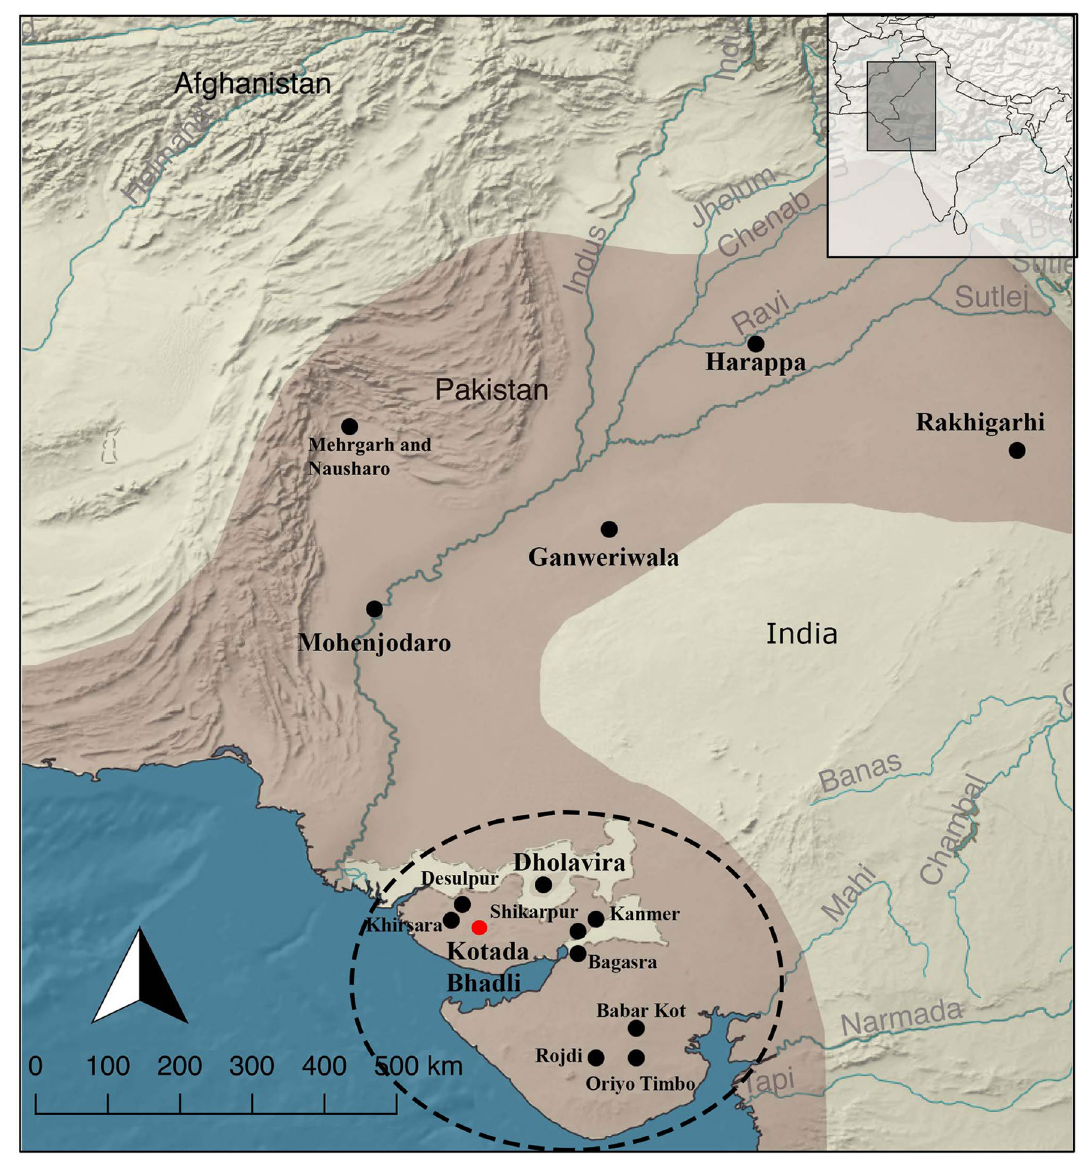
Figure 1. Highlighted map of the Indus Civilization showing the location of major settlements and settlements that are mentioned in this paper. The black dashed lines indicate the region under study and the red dot indicates the site under study. The map was created using QGIS Desktop version 2.18.14 (www.qgis.org), and raster and vector map data was acquired from Natural Earth (https ://www.natur alear thdat a.com/), which